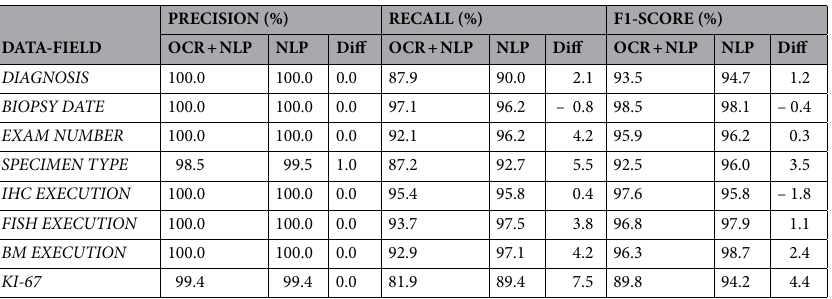
Table 3. Comparison of ARGO performance using OCR + NLP and NLP alone (internal series). ARGO: Automatic Record Generator for Onco-hematology, OCR: Optical Character Recognition, NLP: Natural Language Processing, IHC: Immunohistochemistry, FISH: Fluorescent in situ Hybridization, BM: Bone Marrow, Diff: